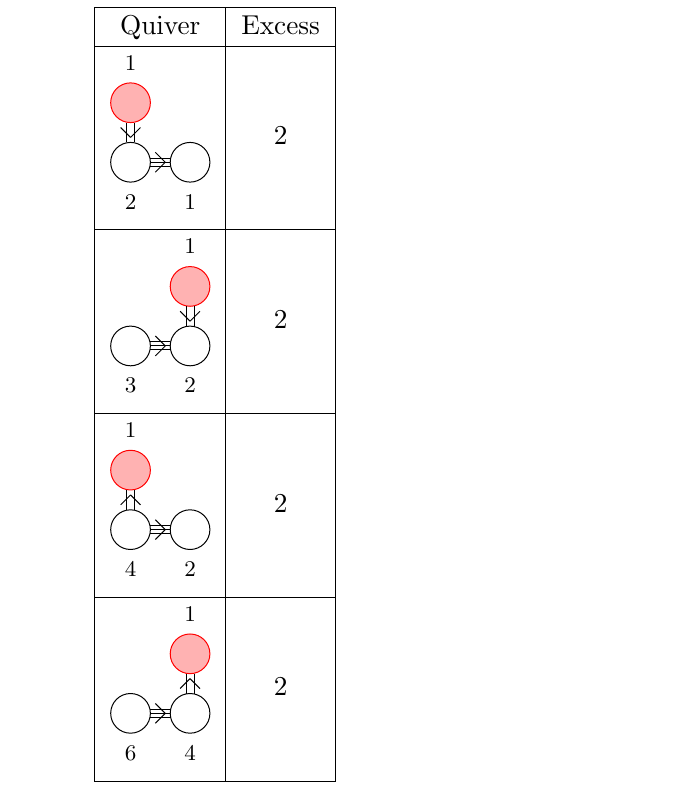
Table 34 . Exotic minimally unbalanced quivers with G = G 2 and an extra double laced edge. In the classi(cid:12)cation of this paper, we (cid:12)nd a raft of quiver theories that are not